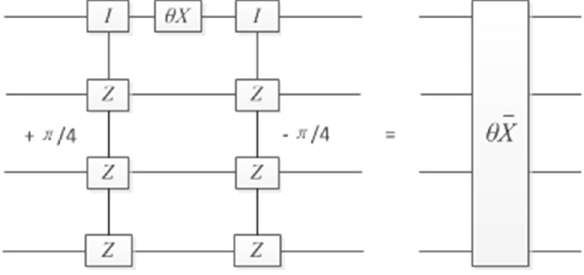
Fig. 1 Parallel implementation of θ ¯ Z for the Q 4 subgroup